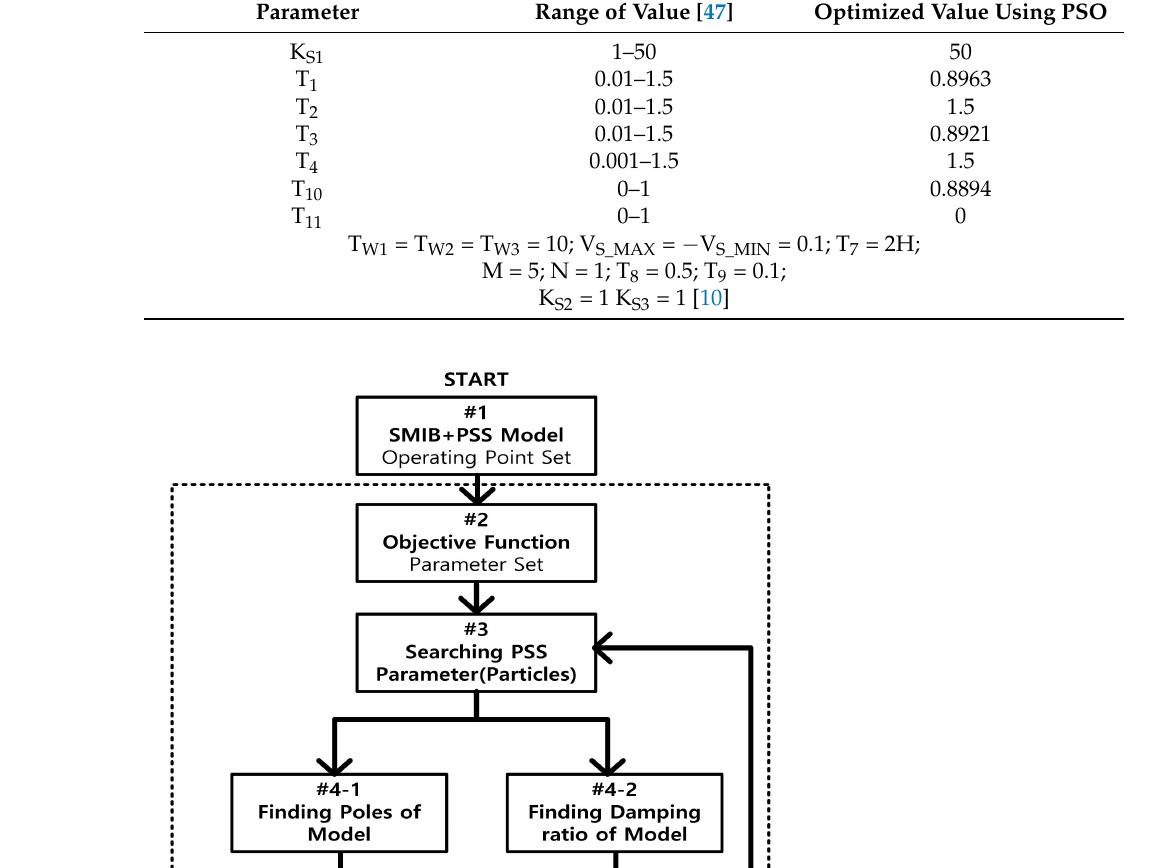
Table 4. Optimized parameters of the PSS for verifying the performance of the µ PSS.